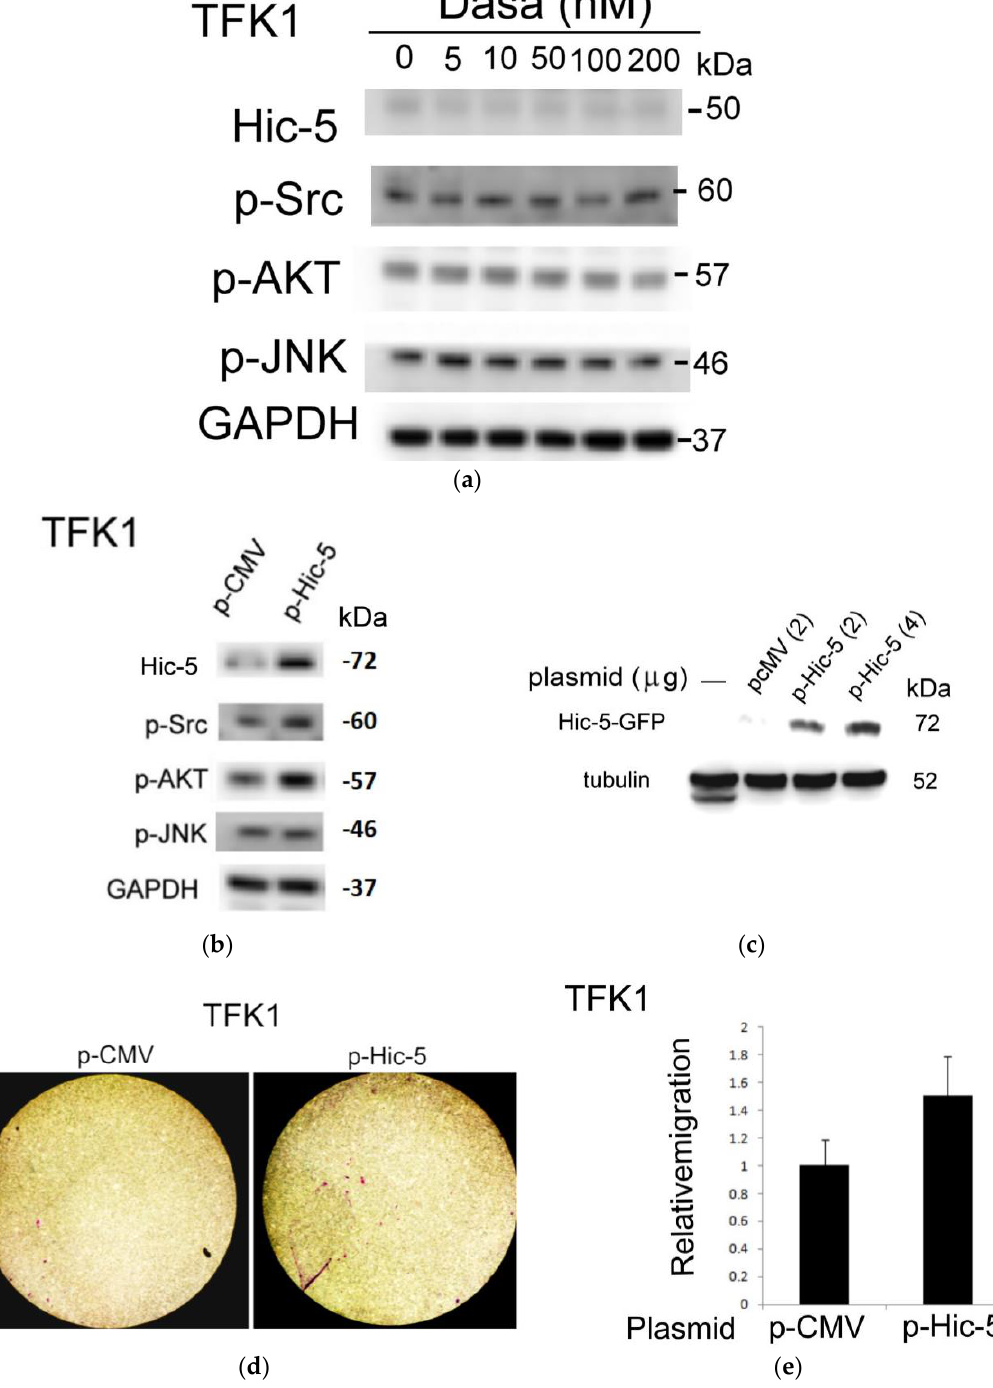
Figure 2. Ectopic expression of Hic-5 significantly enhanced the activation of Src, AKT and JNK for the cell migration of TFK1. TFK1 cells were treated with dasatinib (Dasa) at indicated concentrations ( a ) or transfected with Hic-5 expression plasmid (p-Hic-5) ( b – d ). Western blot of indicated molecules ( a – c ) and transwell migration assay of TFK1 ( d ) were performed. In ( b , c ), the Abs used for detecting p-Hic-5 encoded protein (Hic-5 – GFP fusion protein) were Hic-5 and GFP, respectively, revealing the same molecular weight. In ( d ), the crystal-violet-stained, migrated cells were pictured under 40× magnification. ( e ) is the quantitative data of ( d ) using ImageJ software. Relative motility was calculated taking the data of the p-CMV vector as 1.0. The data shown are representative of two reproducible results.